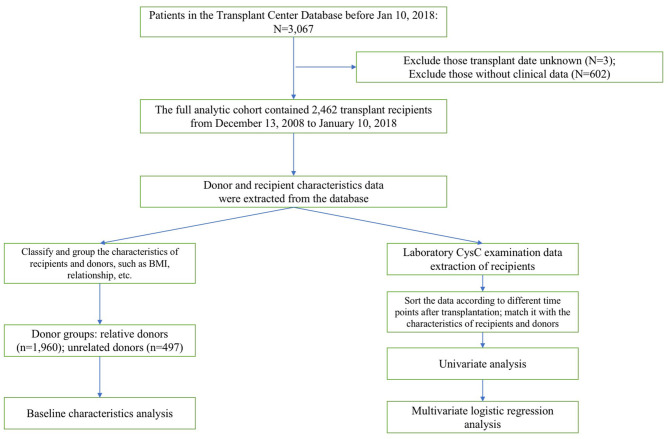
The stepwise approach of the excluded population is detailed in this diagram. Then the subsequent data organization and analysis of included population are demonstrated.